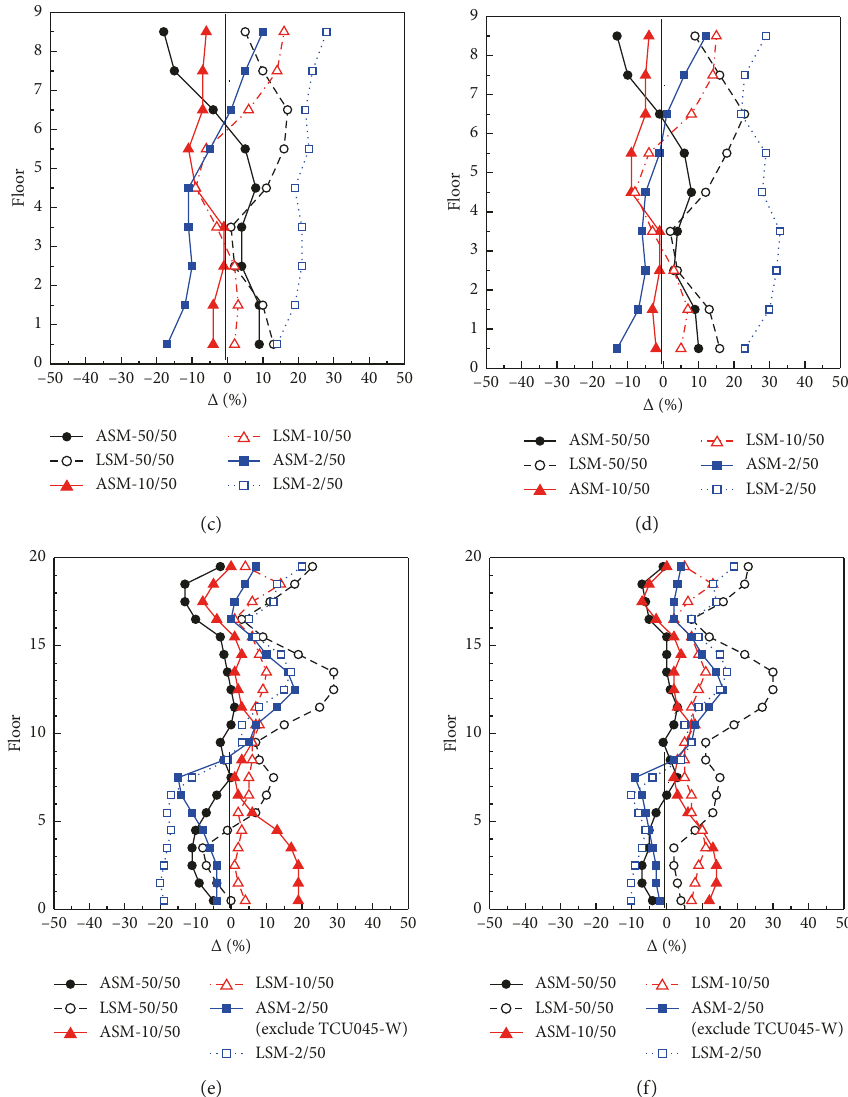
Figure 6: Relative errors of PIDR demands over the height of the 3-, 9-, and 20- structures at the 50/50, 10/50, and 2/50 hazard levels by both ASM and LSM methods based on benchmark mean and median demands: (a) 3-story, mean, (b) 3-story, median, (c) 9-story, mean, (d) 9- story, median, (e) 20-story, mean, and (f) 20-story,